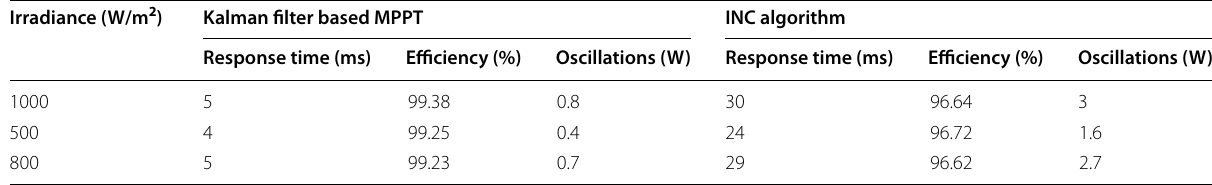
Table 2 Results comparison between the proposed method and INC algorithm at temperature 298.15 K